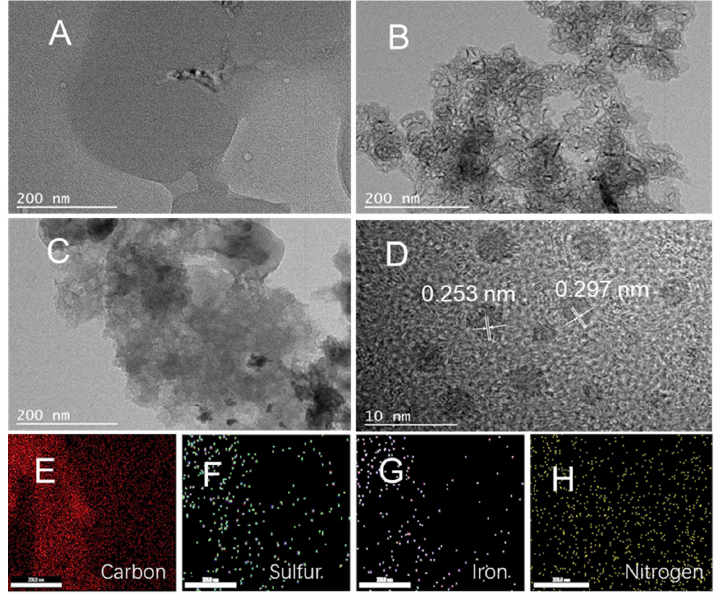
Figure 2. TEM image of PPY-H-CBN ( A ), Fe-BC-600 ( B ), and Fe-BC-900 ( C ); ( D ) HRTEM image of Fe-BC-900; ( E – H ) elemental mapping of C, S, Fe and N for Fe-BC-900. As shown in Figure 3, Raman spectroscopy was further used to investigate the degree of defects and graphitization of Fe-BC-900 composites. The Raman spectra show two peaks at approximately 1340 cm − 1 and 1594 cm − 1 , corresponding to the D and G bands, respectively. I D /I G can provide an indication of the number of structural defects and a quantitative metric of edge plane exposure. The calculated I D /I G of Fe-BC-900 is 0.89, which indicates that the high pyrolysis temperature is more favorable to the formation of gra- phitic crystalline structure, and the high graphitization is beneficial to improve the surface charge transport of the nano-catalyst, which can greatly improve the material sensitivity [36,37].